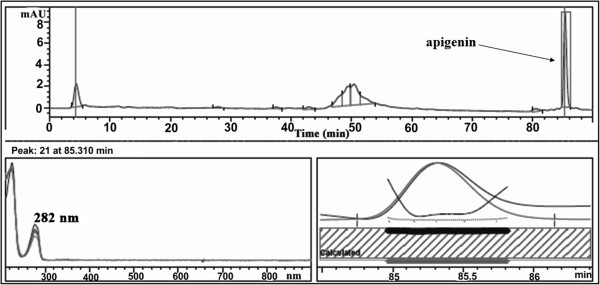
HPLC data for apigenin isolated from the the aqueous extract
of A. adianthifolia
leaves.